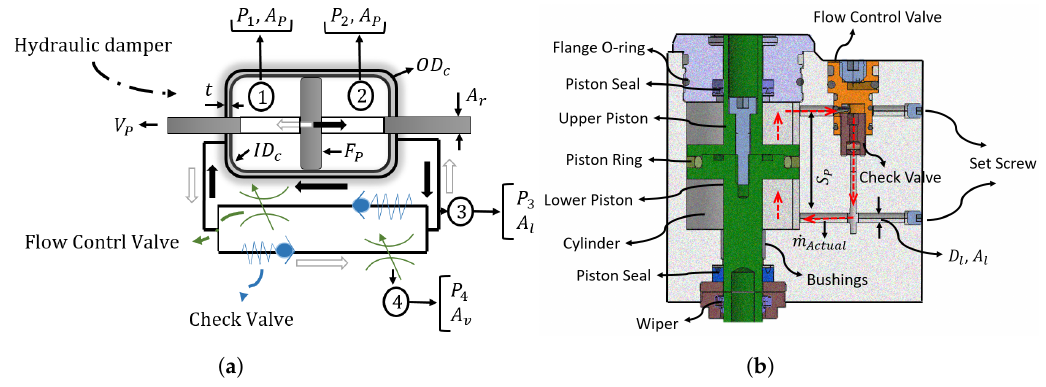
Figure 5. Closed-circuit symbol ( a ) and CAD representation ( b ) of the hydraulic damper. Rod area, piston area, piston force, and piston velocity are shown by A r , A P , F P , and V P , accordingly. The flow control valve’s area ( A v ) regulates the PF (black arrow) and DF (white arrow) flow rate ( ˙ m Actual ) and causes a pressure difference between the piston sides ( P 1 − P 2 ). The cylinder thickness, outer diameter, and inner diameter are represented by t , OD c , and ID c , correspondingly. D l and S P stand for the hydraulic line diameter and the required piston stroke,